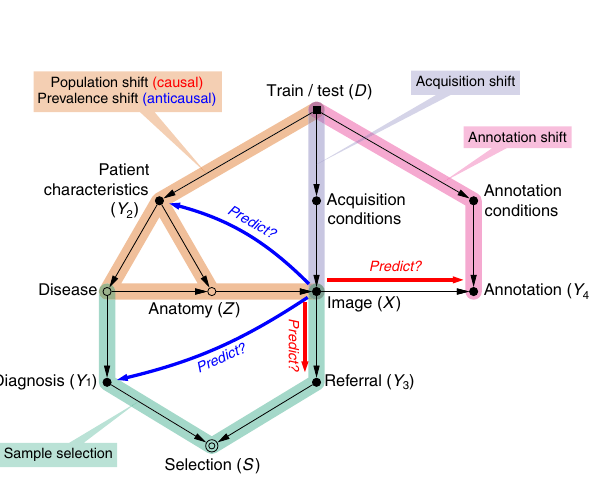
Fig. 5 A ‘ scaffold ’ causal diagram summarising typical medical imaging work fl ows. We believe most practical cases can be adapted from this generic structure by removing or adding elements. Here are represented a variety of possible prediction targets (marked Y 1 – Y 4 ): some anticausal ( Y 1 , Y 2 ) and others, causal ( Y 3 , Y 4 ). ‘ Annotation ’ here refers to any image- derived data, such as lesion descriptions, regions of interest, spatial landmark coordinates, or segmentation maps. Note that annotators will often be aware of the patients' records and diagnoses, in which cases there could be additional arrows from Y 1 or Y 2 towards Y 4